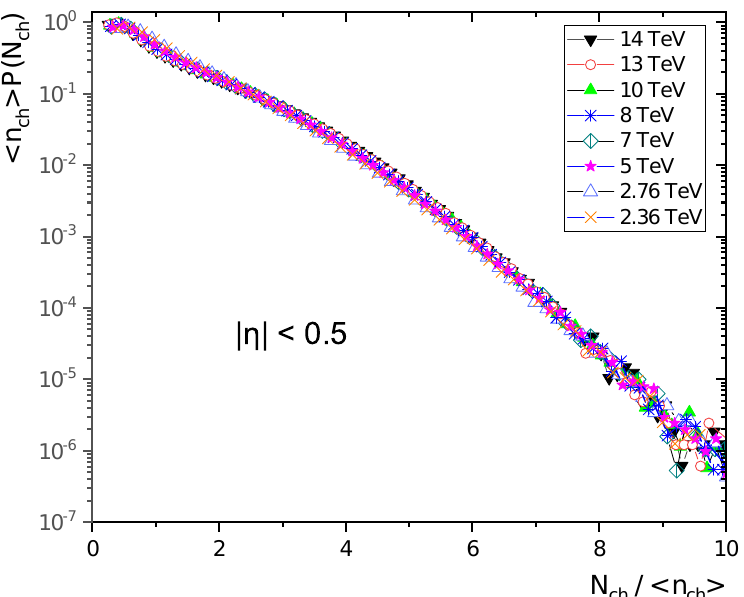
Figure 7. KNO form of the charged particle multiplicity distribution at different energies in pseudo- rapidity | η | < 0.5.